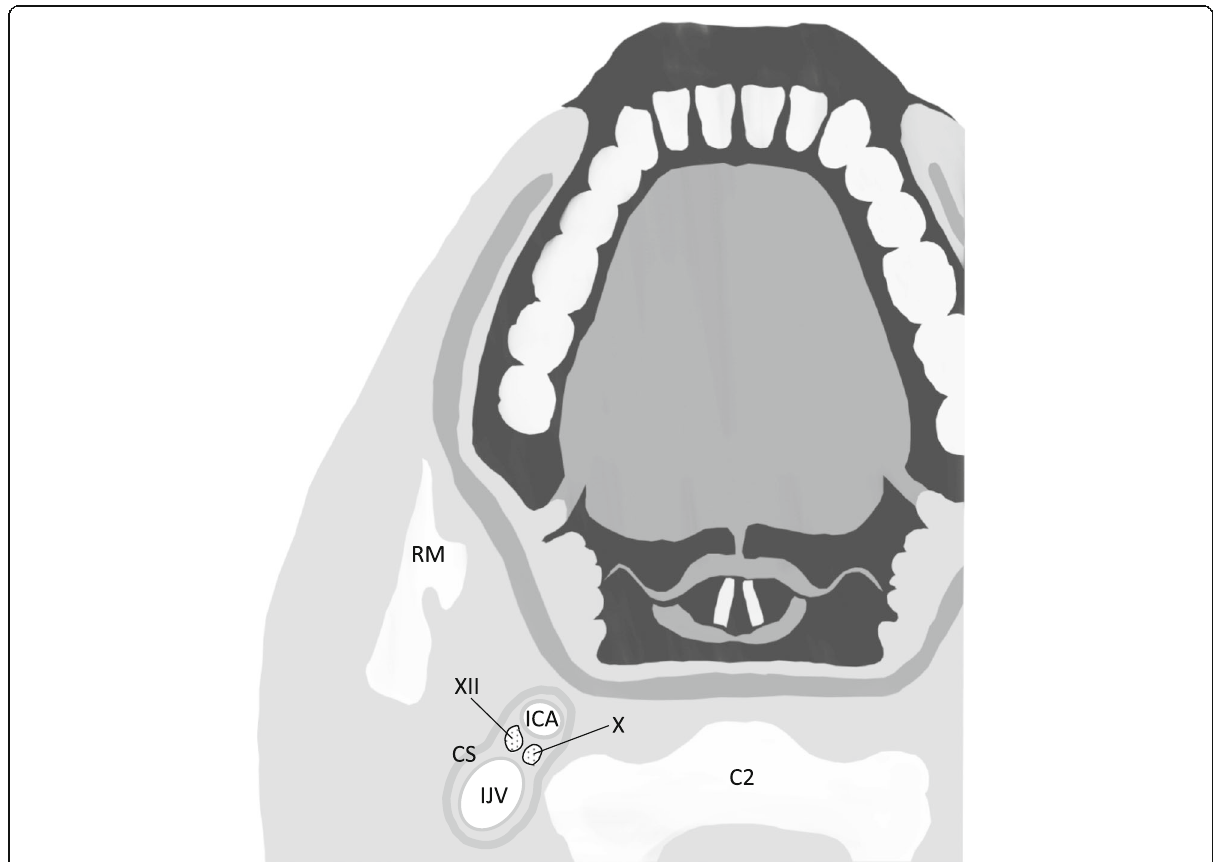
Fig. 1 A sectional illustration of the oropharynx at the level of the second cervical vertebral body (C2). Note that cranial nerves X and XII are adjacent to the carotid sheath (CS) and are located immediately behind the mucosal surface of the lateral oropharyngeal wall. RM ramus of the mandible, IJV internal jugular vein, ICA internal carotid